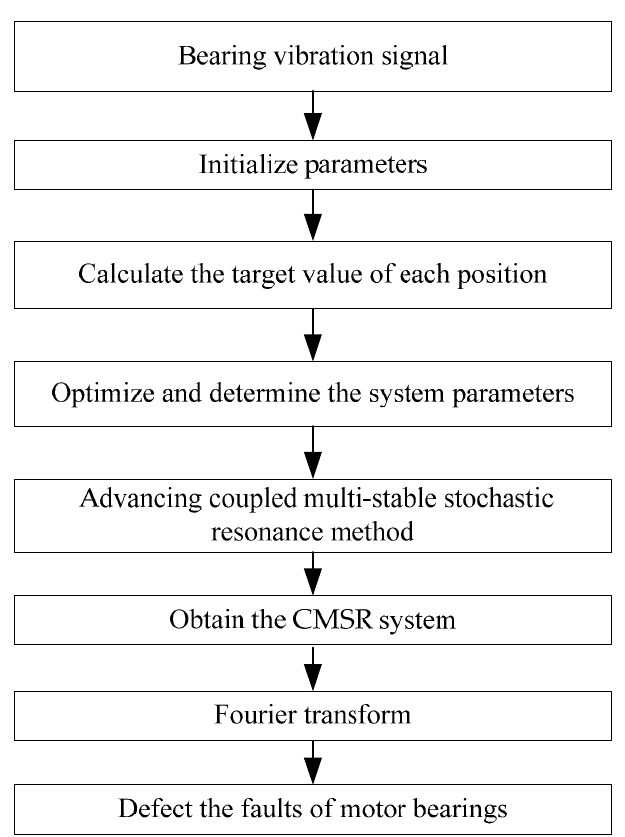
Figure 3. The flow of the CMSR system.